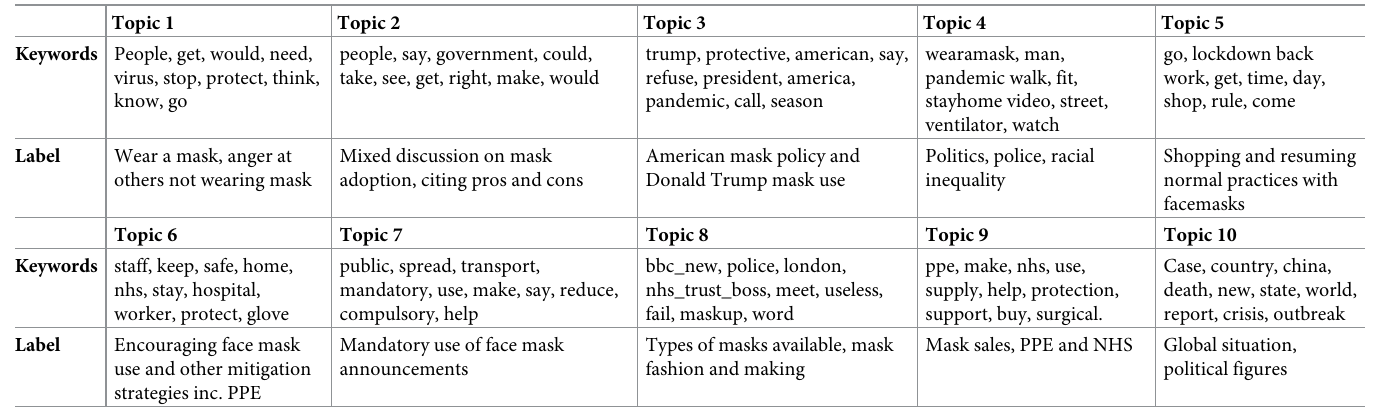
Table 4. Topic modelling categories.